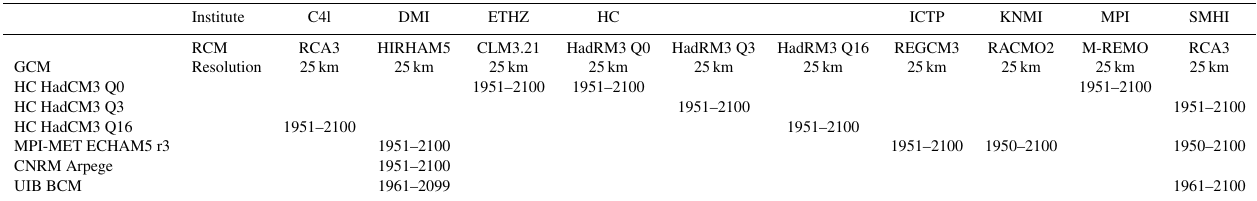
Table A2. Fourteen selected GCM/RCM simulations (SRES A1B) from the ENSEMBLES project (Van der Linden and Mitchell, 2009).